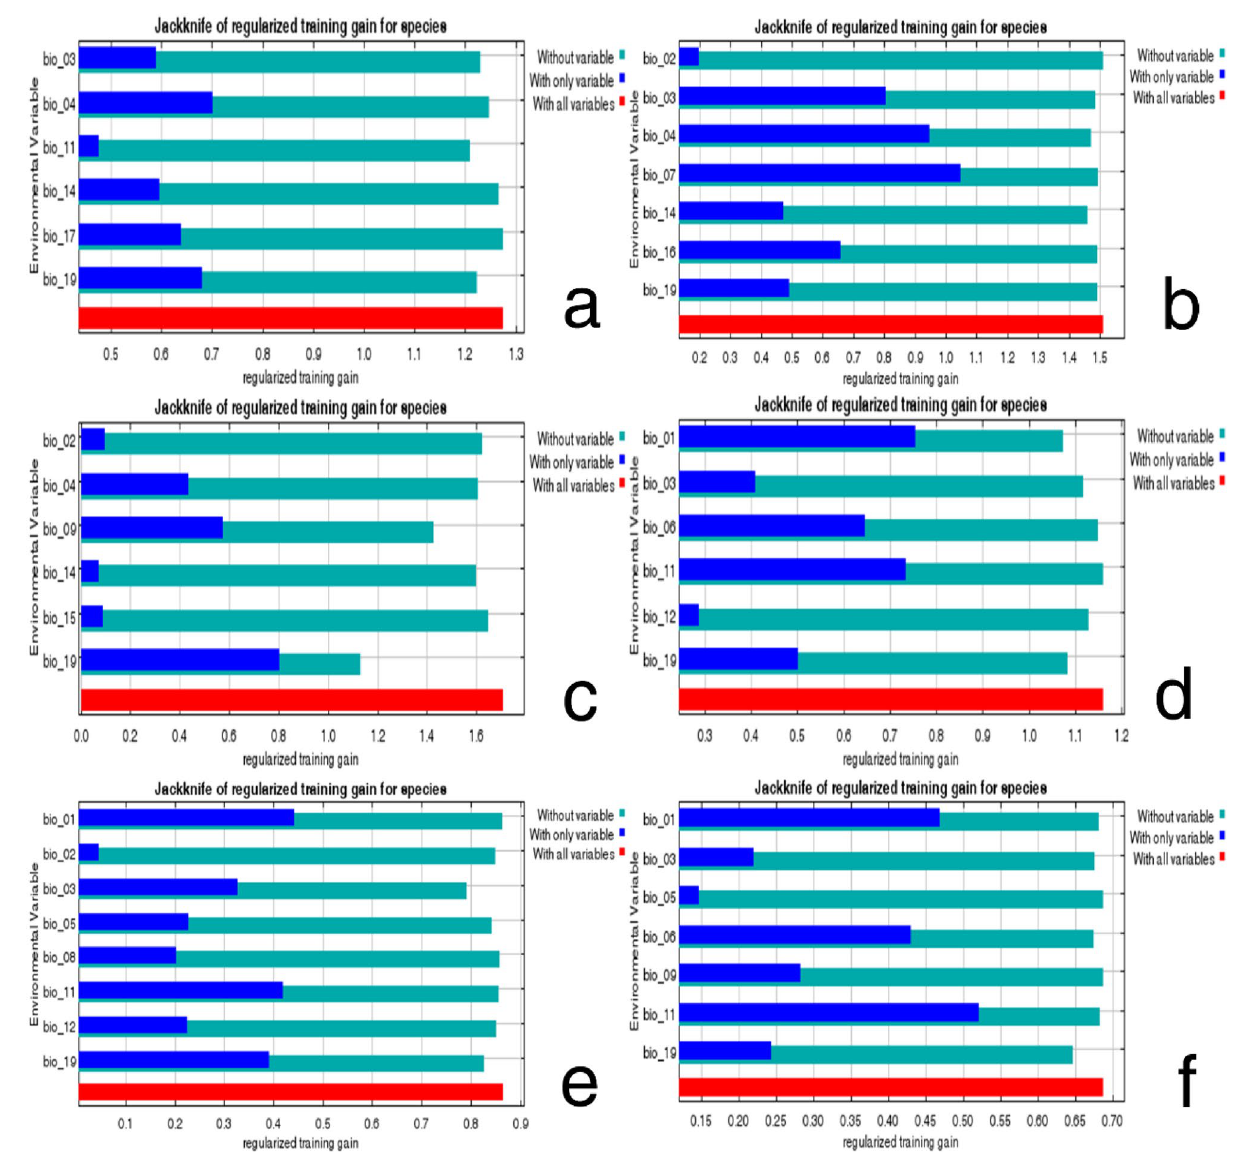
Figure 10. Relative importance of environmental variables of six important quarantine species based on the Jackknife test: ( a ) Crenidorsum aroidephagus , ( b ) Aleurothrixus trachoides , ( c ) Paraleyrodes minei , ( d ) Nasonovia ribisnigri , ( e ) Macrosiphum euphorbiae , ( f ) Viteus vitifoliae. Figures were created using R version 4.04 (https:// www.r- proje ct.